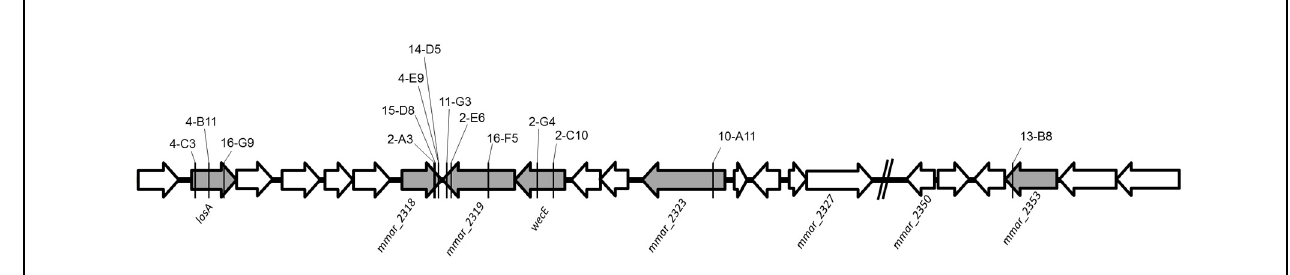
FIGURE 2 | The transposon insertion sites of mutants within lipooligosaccharide (LOS) synthesis locus. The six genes with gray color ( losA , mmar_2318 , mmar_2319 , wecE , mmar_2323 and mmar_2353 ) within LOS synthesis locus had transposon insertions in different sites. The solid line indicates the transposon insertion.